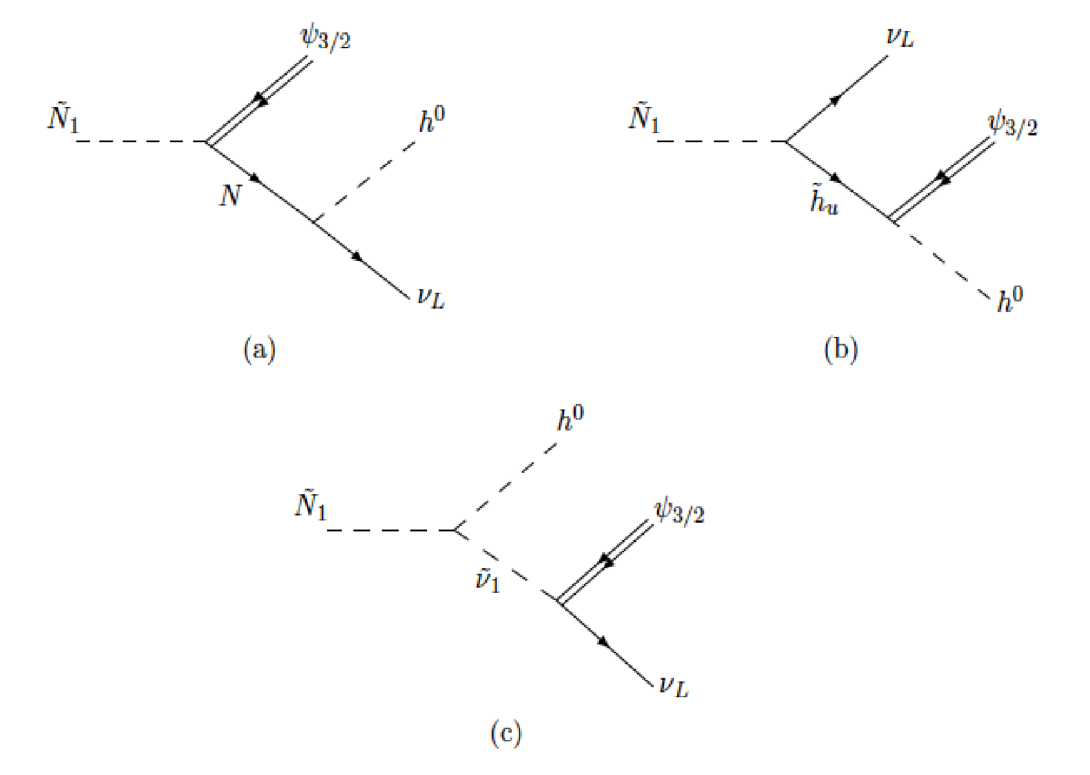
. The diagrams 3 = 2